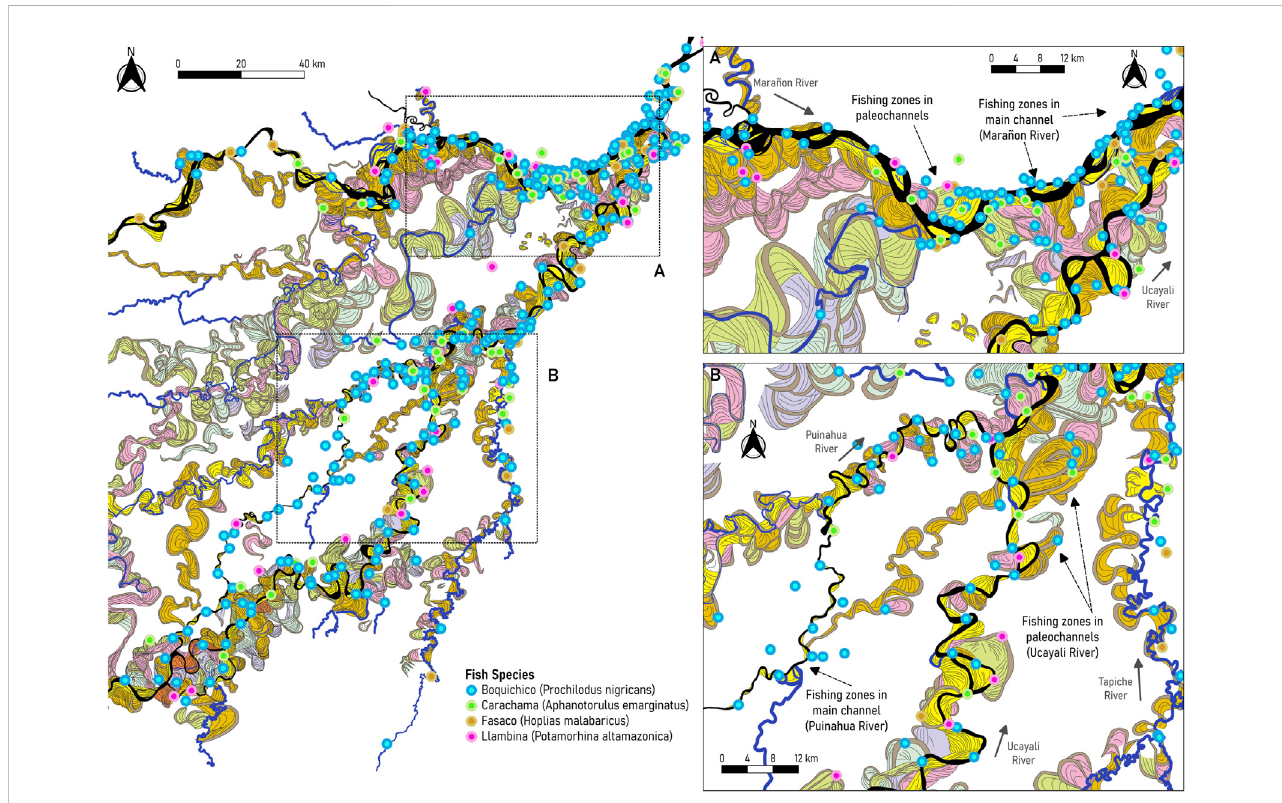
FIGURE 9 Most representative and abundant fi sh species for local commercial fi shing in the PSNR (A) along the Marañon River, and (B) along the Ucayali and Puinahua rivers. Fisheries data provided by Wildlife Conservation Society,